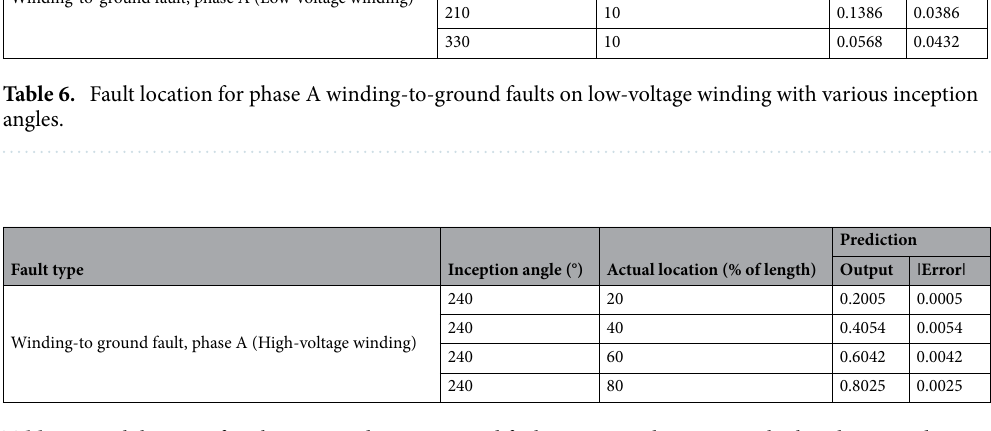
Table 7. Fault location for phase A winding-to-ground faults at various locations on high-voltage